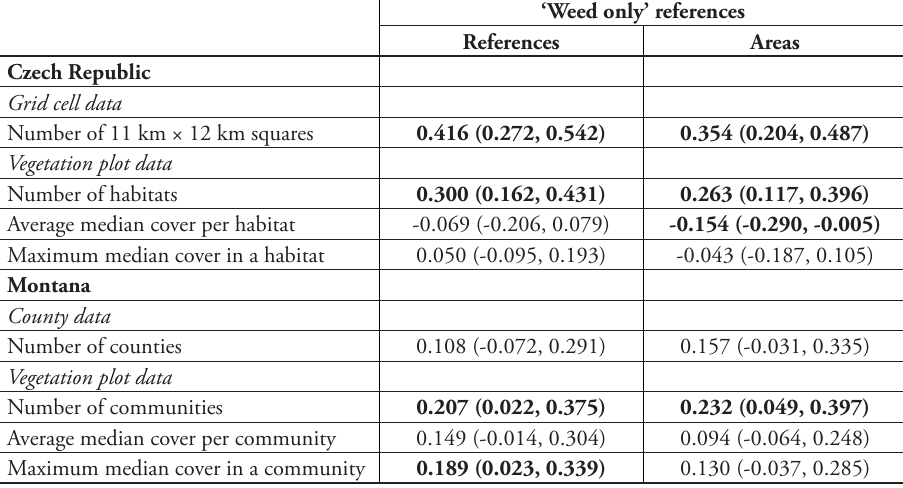
table s4. Spearman’s ρ correlation coefficients (and bootstrapped, bias-corrected 95% confidence in- tervals) of relationships between GCW-derived invasiveness measures with ‘weed-only’ non-target region references included, and regional measures of species abundance and distribution from vegetation plot data in the Czech Republic and Montana. Values in bold are ρ coefficients significantly greater than zero. GCW measures included number of references and the number of areas occupied according to ‘weed only’ references in the Global Compendium of